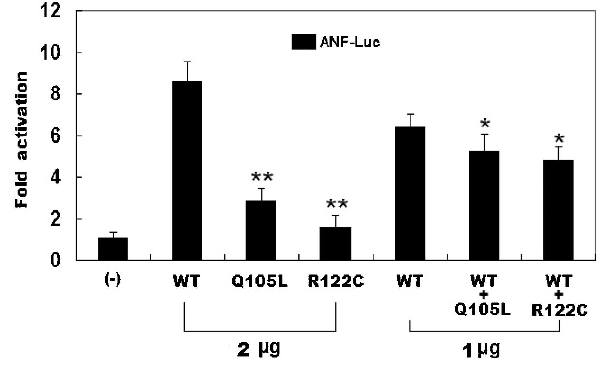
Figure 4 – The functional defects associated with the PITX2c mutations. The activation of an atrial natriuretic factor (ANF) promoter-driven luciferase reporter in the CHO cells by PITX2c wild-type (WT), Q105L-mutant, or R122C-mutant, alone or in combination, demonstrated a significantly decreased transacti- vational activity by the mutant proteins. The experiments were performed in triplicate, and the means and standard deviations are shown. ** indicates p , 0.001 and * denotes p , 0.01, when compared with the same amount (2 m g) of wild-type